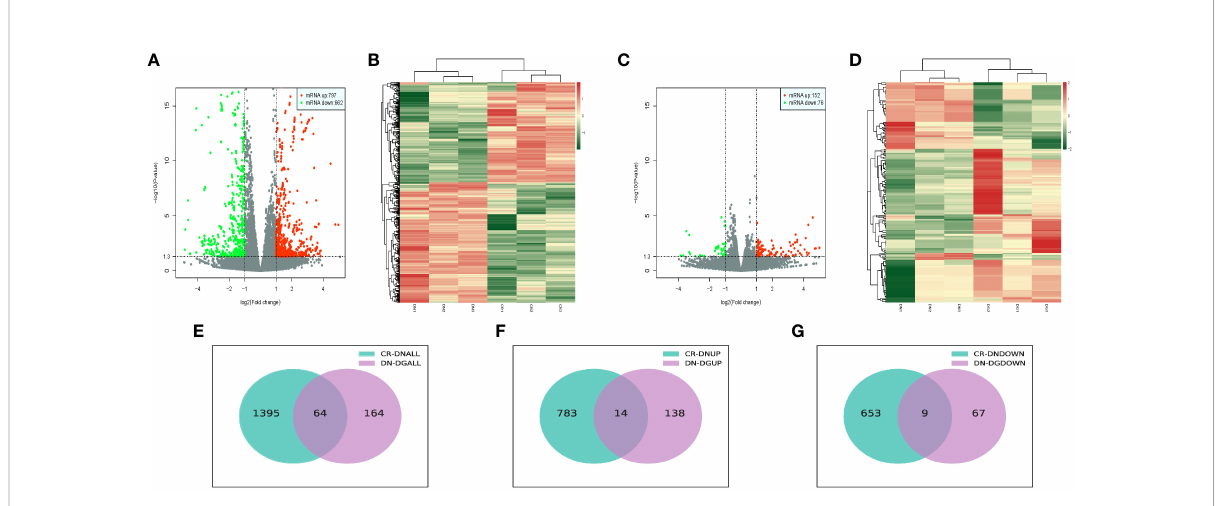
FIGURE 3 Differentially expressed mRNAs in DN (n=3). (A, B) Volcano plots (A) and heatmaps (B) for comparison between CR and DN. (C, D) Volcano plots (C) and heatmaps (D) for comparison between DN and DG. (E) Overlap of the differentially expressed mRNAs in the comparisons between CR vs DN and DN vs DG. (F) Upregulated differentially expressed mRNAs in the comparisons between CR vs DN and DN vs DG. (G) Downregulated differentially expressed mRNAs in the comparisons between CR vs DN and DN vs DG. CR, control group; DN, diabetic nephropathy group; DG, dapagli fl ozin group.